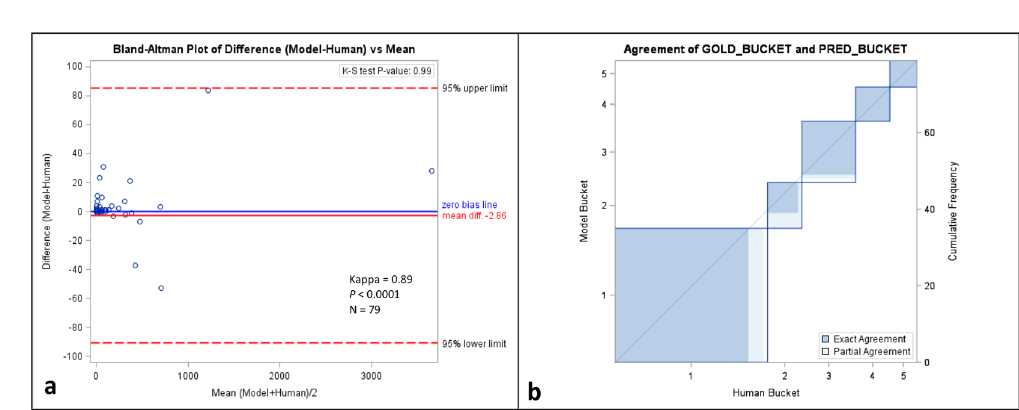
Fig. 1 Comparison of automated scoring using deep learning and manual scoring in a retrospective cohort. Bland – Altman plot ( a ) and Cohen ’ s Kappa statistic agreement plot ( b ) comparing retrospective automated scoring of gated AI model to manual scoring of CAC using gated coronary CT exams. Please refer to Supplementary Fig. 1 for a zoomed version of the Bland – Altman